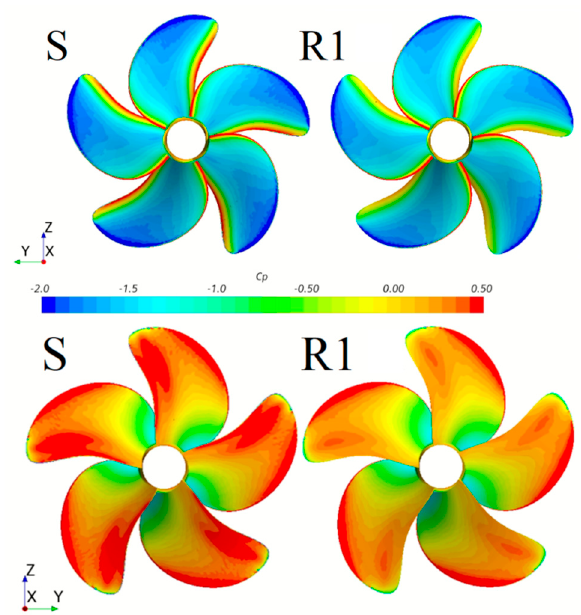
C distribution on KP505 surface for suction ( upper ) and pressure ( lower ) Figure 12. The obtained Figure 12. The obtained C P distribution on KP505 surface for suction ( upper ) and pressure ( lower ) P side of side of propeller.